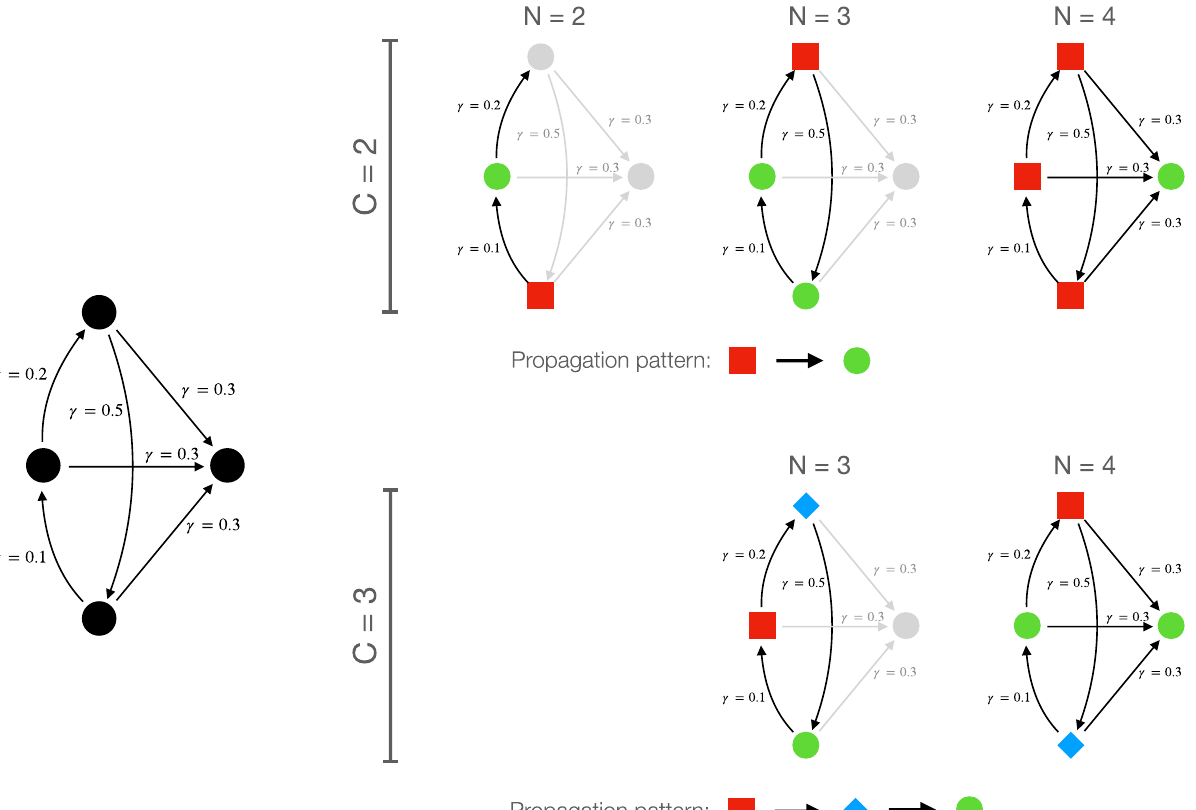
Figure 8. Evolution of the clustering with the size of the system. (Left) Graphical representation of a toy model composed of four dynamical units (nodes), pairwise linearly coupled (arrows). The number near each arrow indicates the corresponding coupling strength γ . (Right) Evolution of the best clustering when changing the number of analysed nodes N (from left to right), and the number of clusters C (from top to bottom). Node colour and shape represent the detected role, including net forcing (red squares), intermediary (blue diamonds, only for C = 3 ) and net forced (green